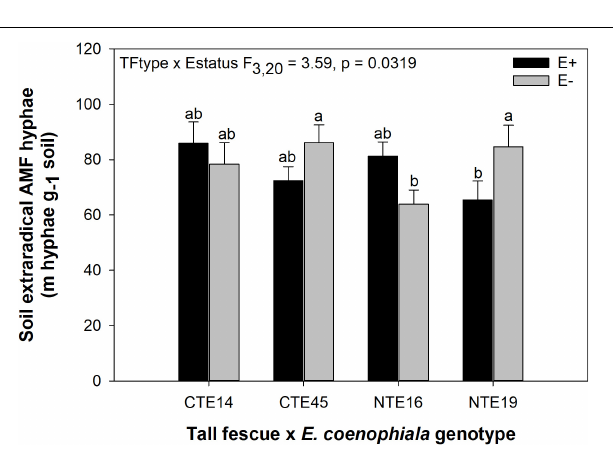
FIGURE 2 | Interactive effects of tall fescue symbiotic genotype and endophyte status on the length of extraradical AMF hyphae (ERH) in root-associated soil. Bars indicate means ± 1 S.E. Bars sharing no common letter (a,b) indicate significant differences between means ( α =